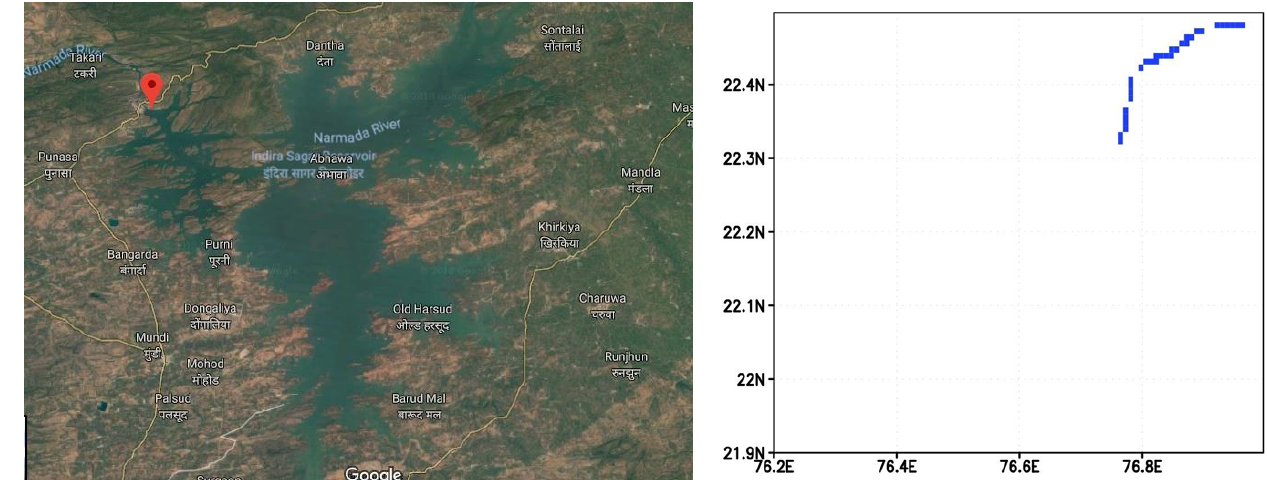
Figure 4. Indira Sagar Reservoir on Google Earth (to the left) (Google Earth, https://earth.google.com/web/, 2019) and on ECOCLIMAP2 (to the right).